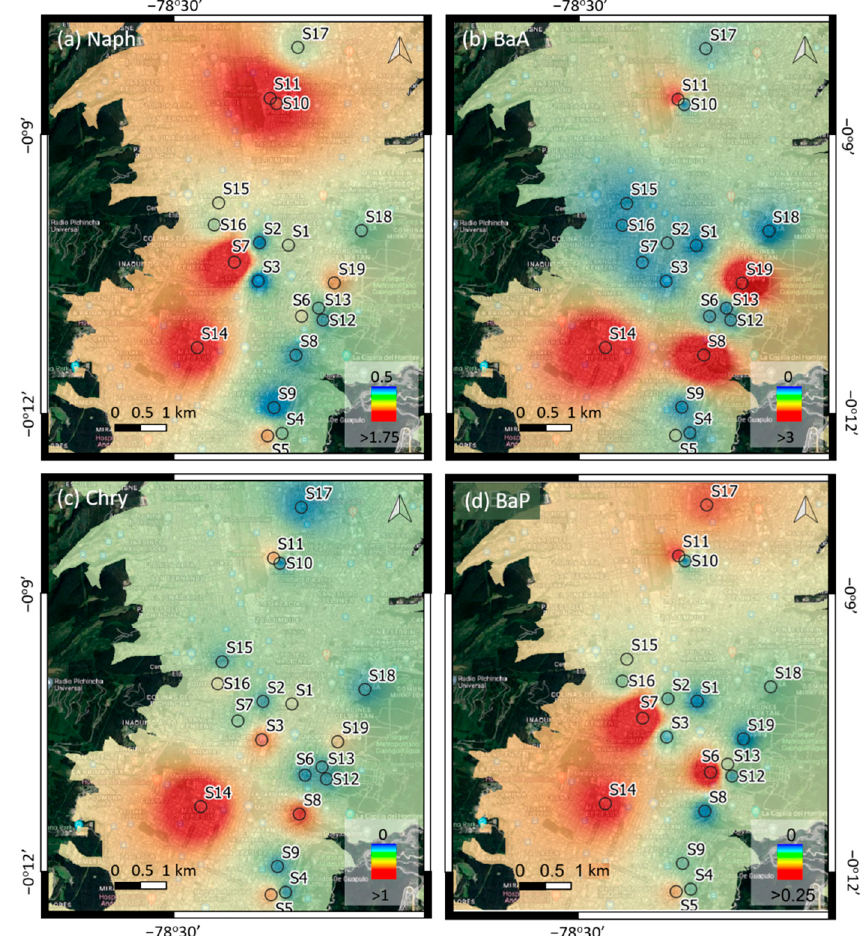
Figure 4. Distribution patterns of the concentration of PAHs studied in the city of Quito.